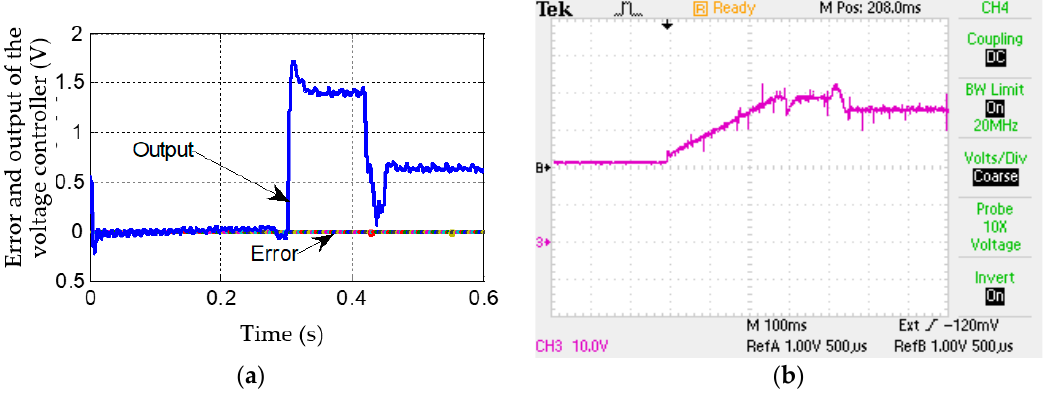
Figure 25. Time evolution of some quantities during the start-up process followed by compensation at nominal load and then compensation at reduced load: ( a ) error (in black) and output of the voltage controller (in blue); ( b ) oscillogram of the DC-capacitor voltage. Table 6. The main experimental energetic performances of the adaptive control, at reduced load.